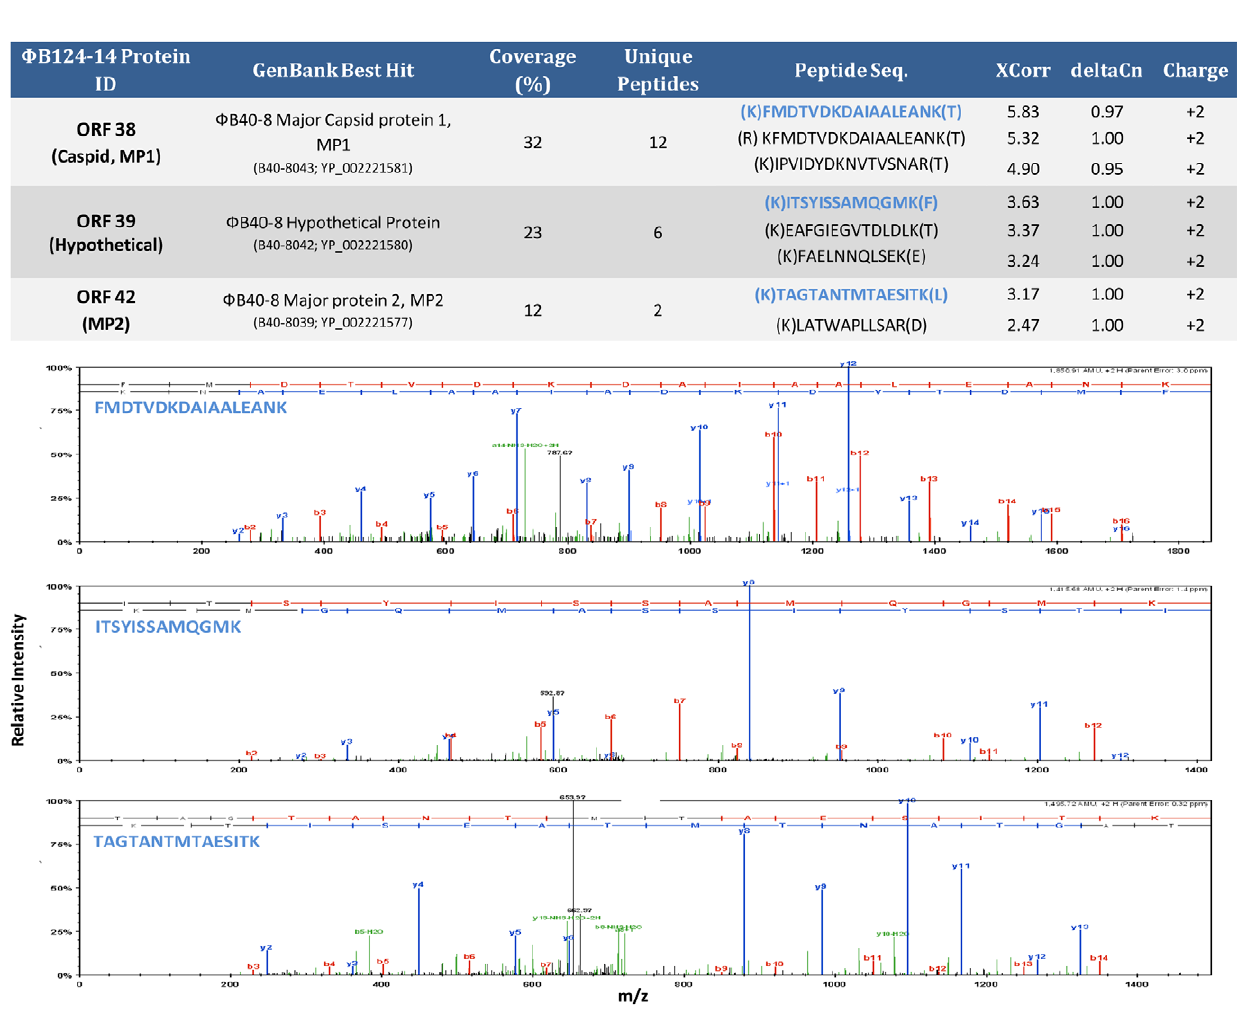
Figure 4. Analysis of the mature w B124-14 proteome. Spectra of w B124-14 proteins identified by tandem mass spectrometry. Example peptide spectra for each of the three proteins identified are shown. Table provides protein coverage and associated number of unique peptides matched and the sequence of the top four matches (ranked by by XCorr score).